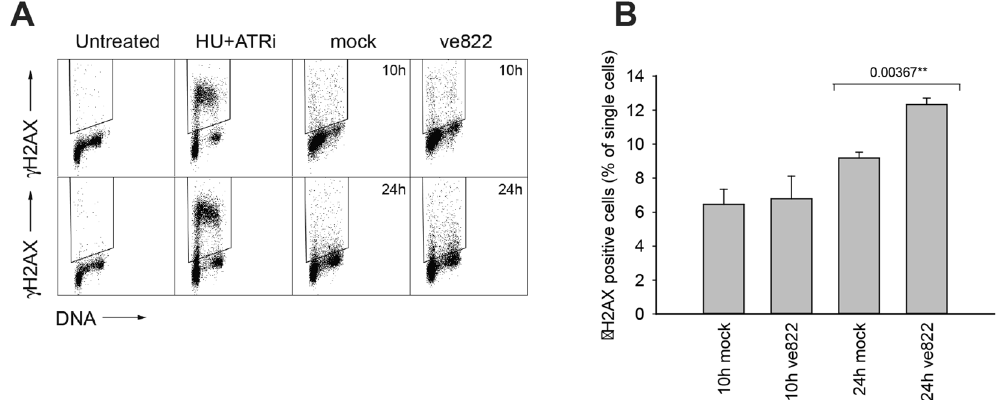
Figure 7. DNA damage upon ATR inhibition in G1 phase ( A ) Dot plot showing DNA content versus γ H2AX intensity in individual U2OS cells 10 or 24 hours after release from mitotic arrest. ATRi ve822 160 nM was added 1 hour after release from the mitotic arrest and removed 4 hours later (see 5 A). Each time point was stained in a barcoding set that also included a positive (2 hours 2 mM HU + 160 nM ve822 in exponentially growing cells) and negative control sample to allow correct gating of γ H2AX-positive cells. ( B ) Quantification of γ H2AX-positive cells shown in D. Error bars show standard deviations of three independent experiments. Numbers represent p-values from a two-tailed